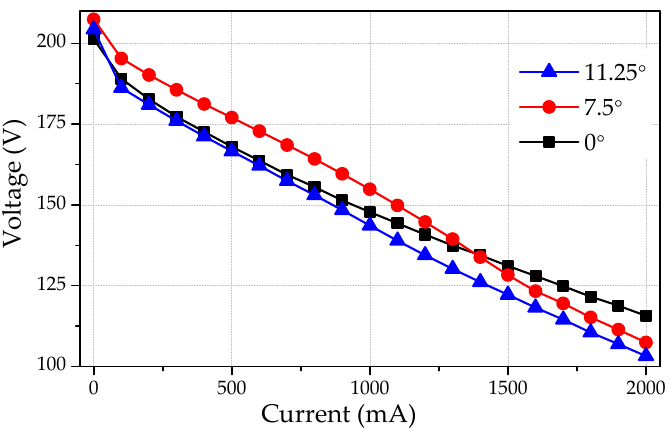
Figure 13. Output voltage vs. load current for three shifting angles (0 ◦ , 7.5 ◦ , and 11.25 ◦